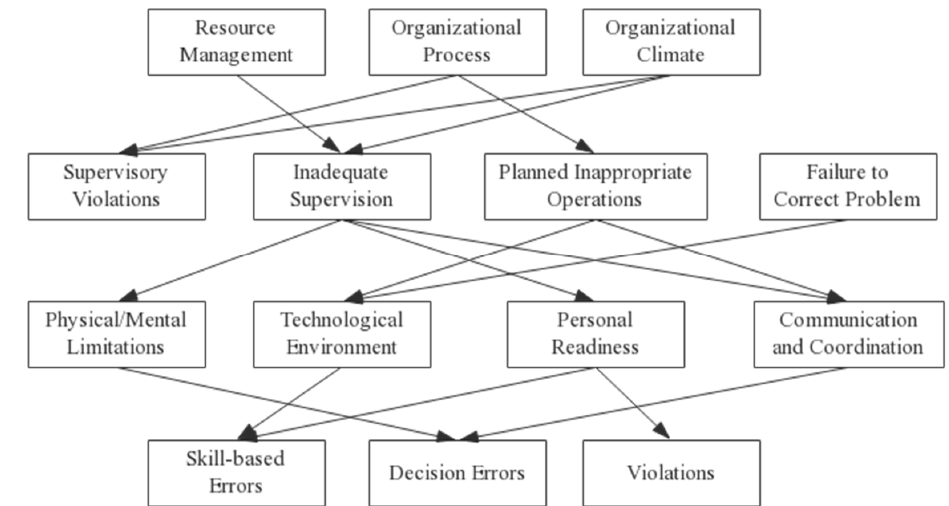
ff ect diagram of human factors in hazardous chemical storage Figure 2. Cause and effect diagram of human factors in hazardous chemical storage accidents. Figure 2. Cause and e